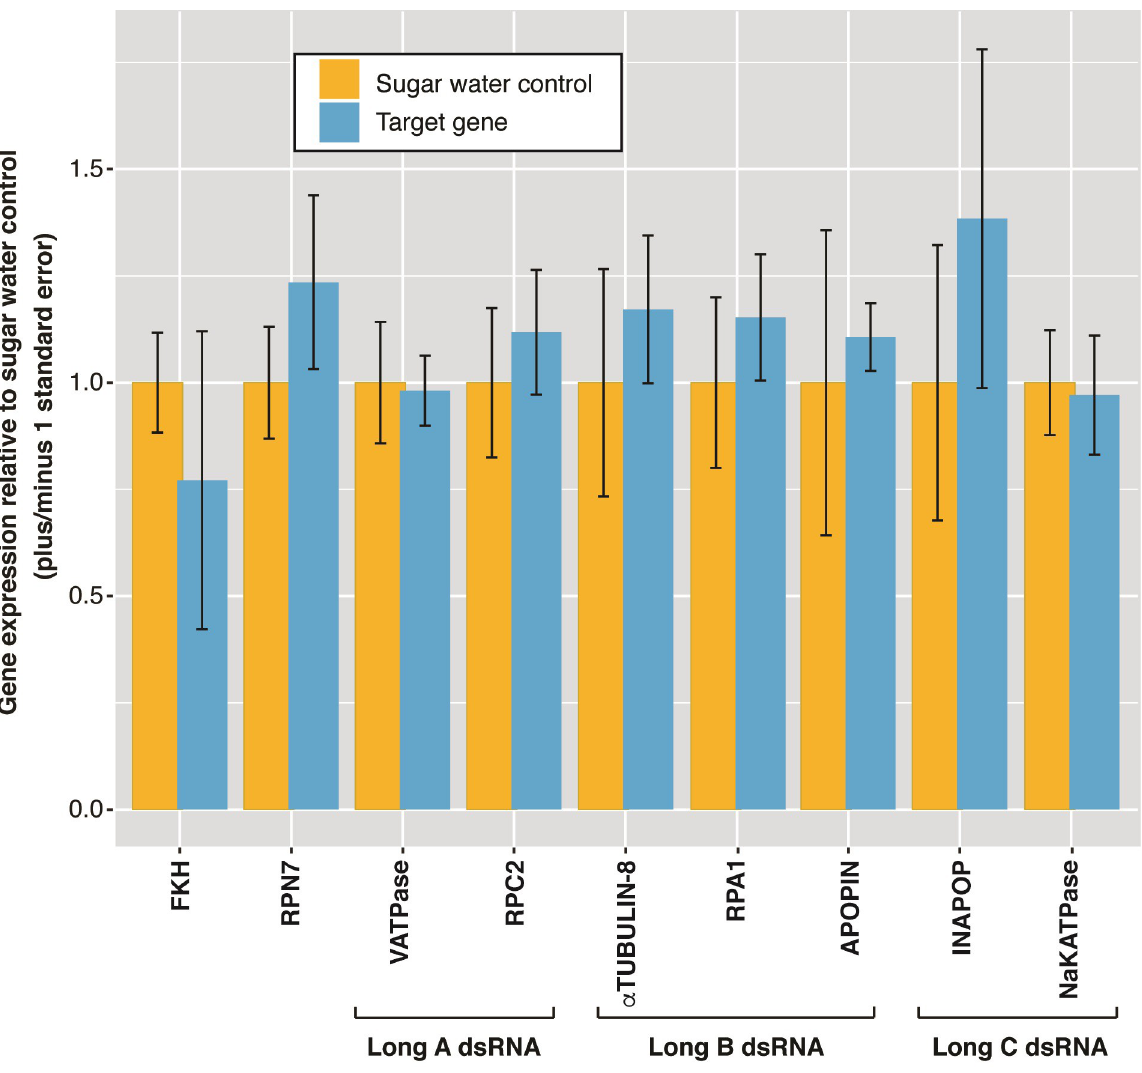
Fig 5. Relative gene expression for single gene dsRNA targets fed alone (FKH and RPN7) or in concatenated form to forager P . dominula when compared to the sugar water controls. Each bar represents the pooled mean ± SE for three wasps, compared to three control wasps. Note that CaM is not shown in this graph but in S1